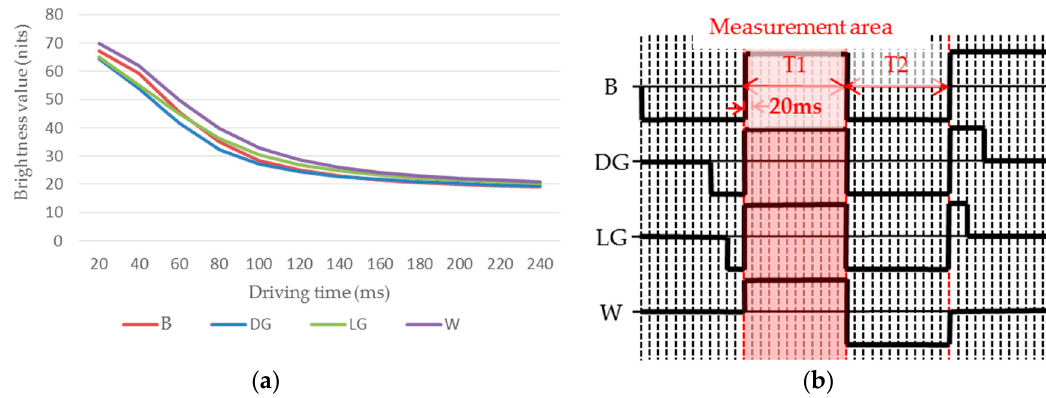
Figure 3. Brightness change curve of the improving particle activity phase at different initial grayscale. ( a ) The brightness curve of the T1. ( b ) The driving waveform used in measurements. The initial brightness values of the four different initial grayscale are not the same, but the brightness values can be closed together after the image erasure phase in the driving waveform (the phase before T1). Hence, when the measuring area is T1 phase, the brightness value is consistent. The motion speed of particles is directly proportional to the change speed of the display brightness value. The motion of particles is shown as the brightness change of EPDs. In Figure 3a, it can be